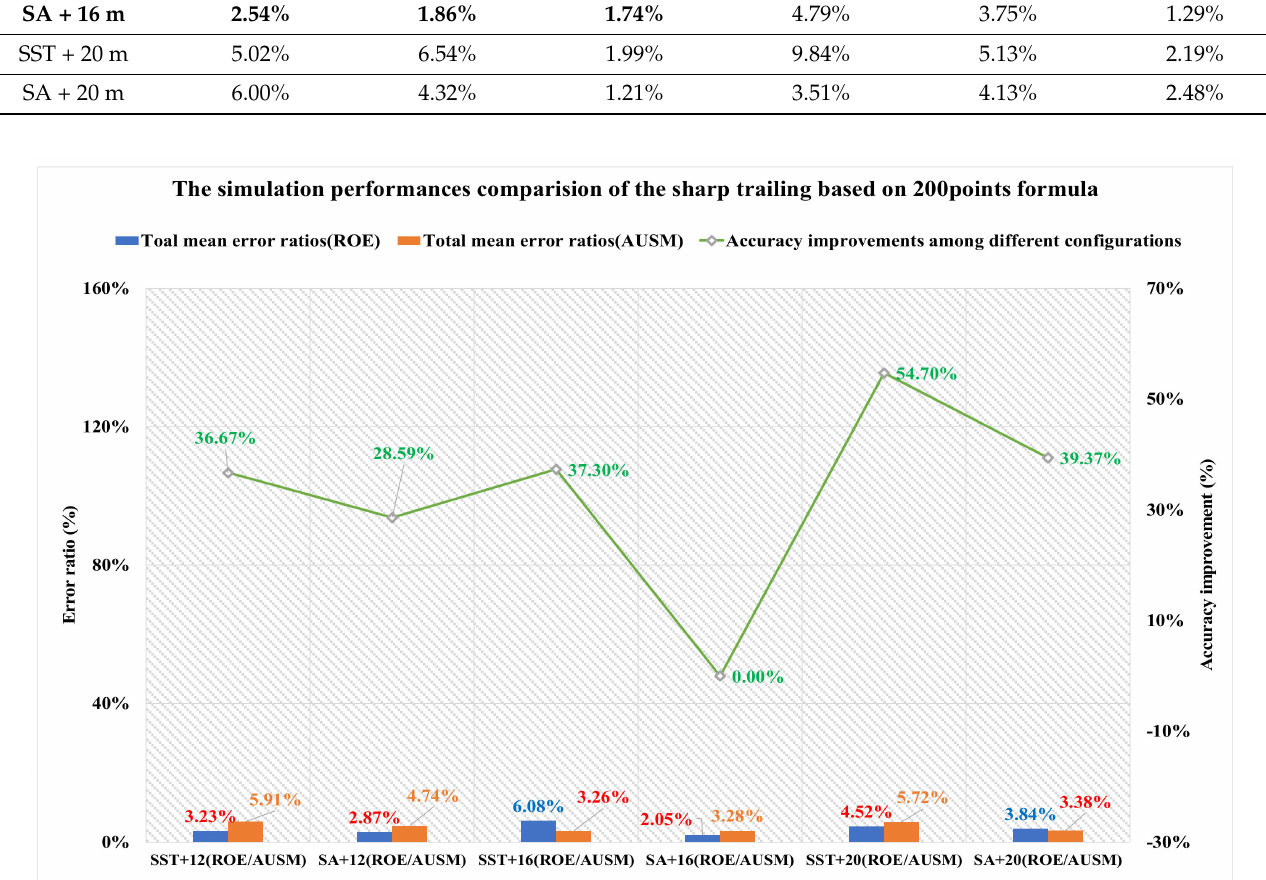
Figure 19. Comparison of the simulation performances of the sharp trailing edge based on 200 points formula under different simulation